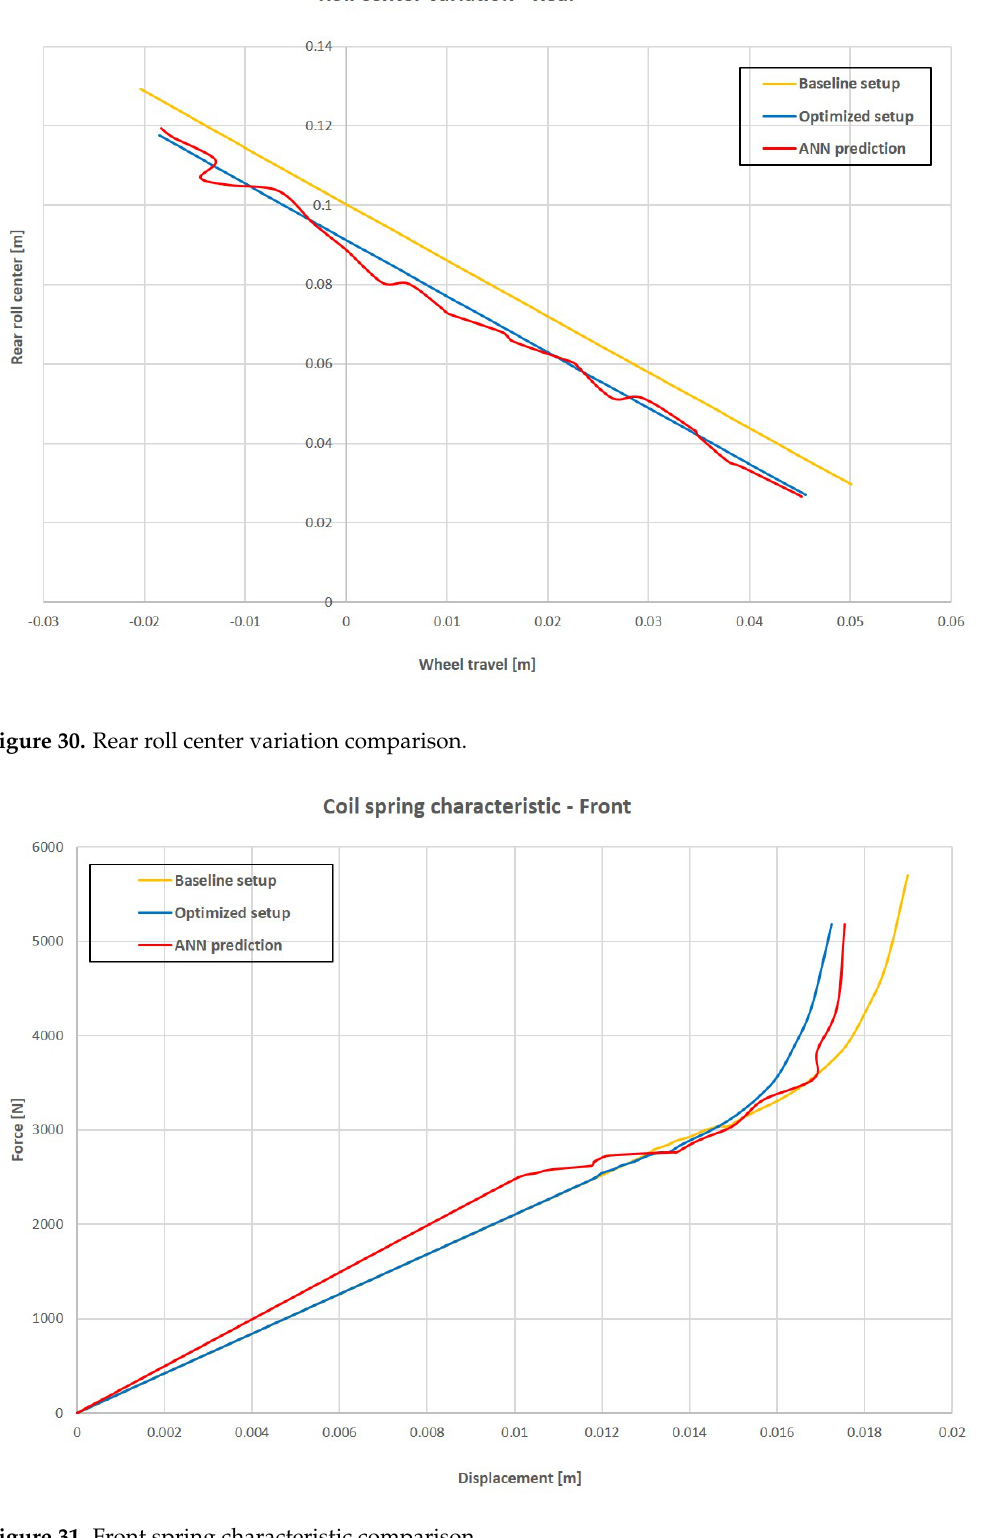
Figure 31. Front spring characteristic